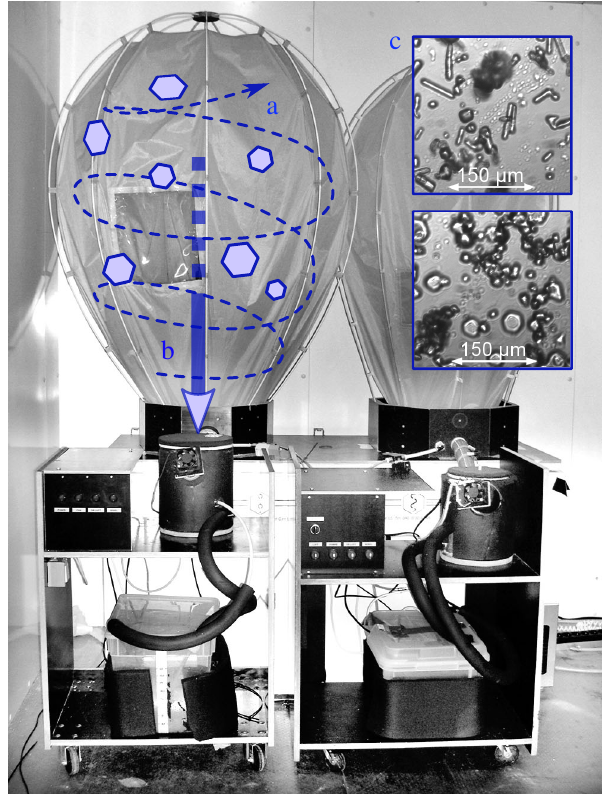
Figure 15. Ice crystal generators. A jet of air (a) circulates the flow, allowing for ice crystal growth. When the crystals are large enough, they fall into a chest freezer (b) . Microscopic images of ice particles inside the cloud chambers (c) . Both plate crystals and needles can be